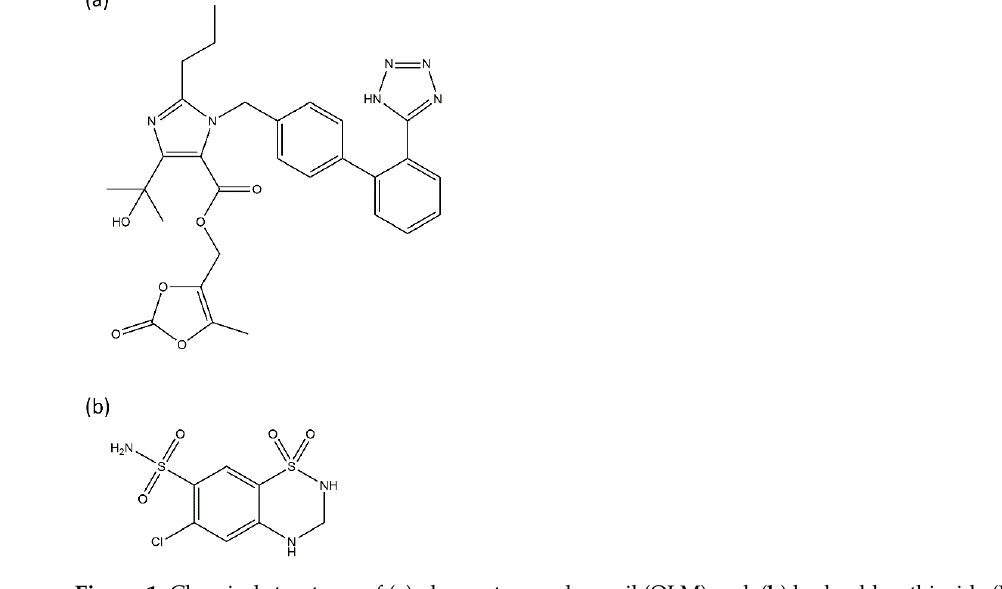
Figure 1. Chemical structures of ( a ) olmesartan medoxomil (OLM) and, ( b ) hydrochlorothiazide (HCT).